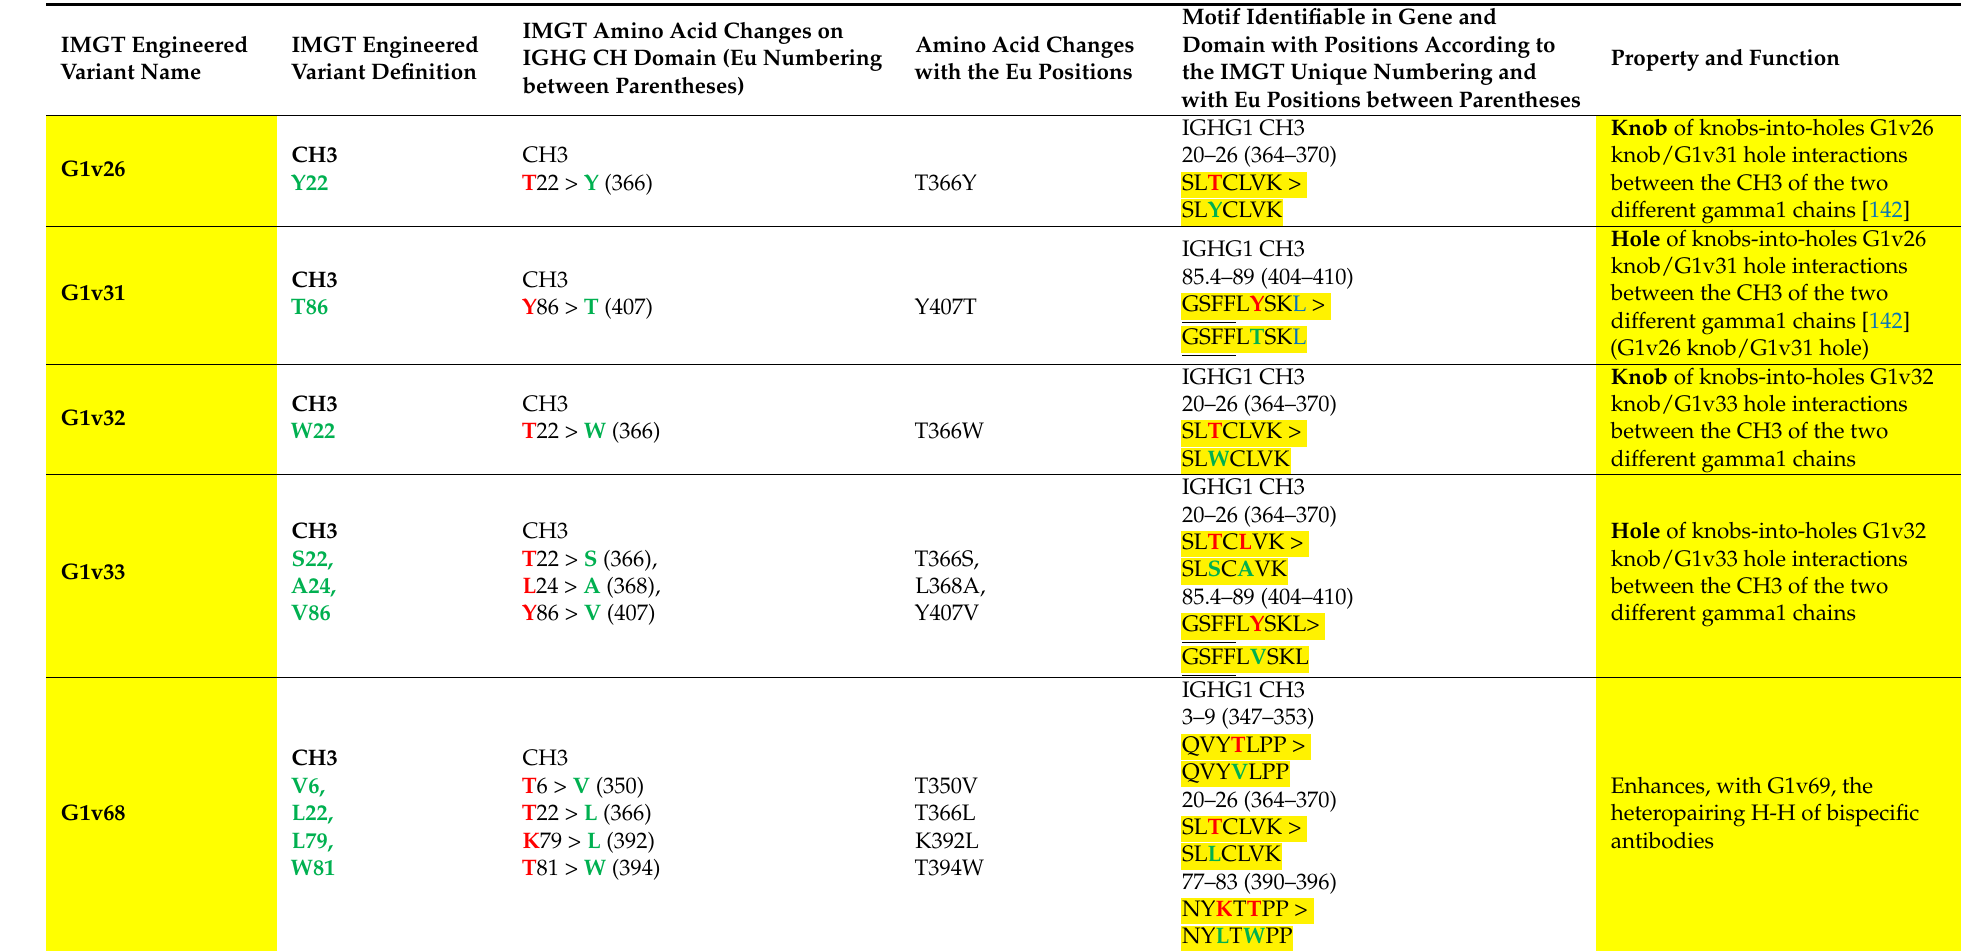
Table 18. IMGT nomenclature, Eu positions and IMGT motif of engineered Fc variants involved in knobs-into-holes and the enhancement of heteropairing H-H of bispecific antibodies (Structure